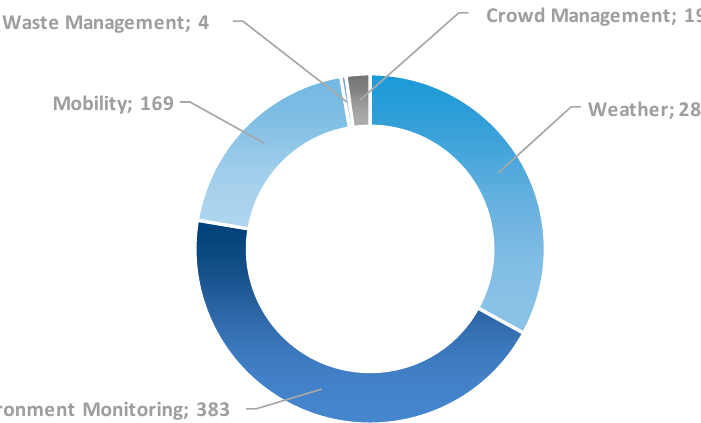
Figure 7. Distribution of active sensors per application sub-domain within the Smart City domain.